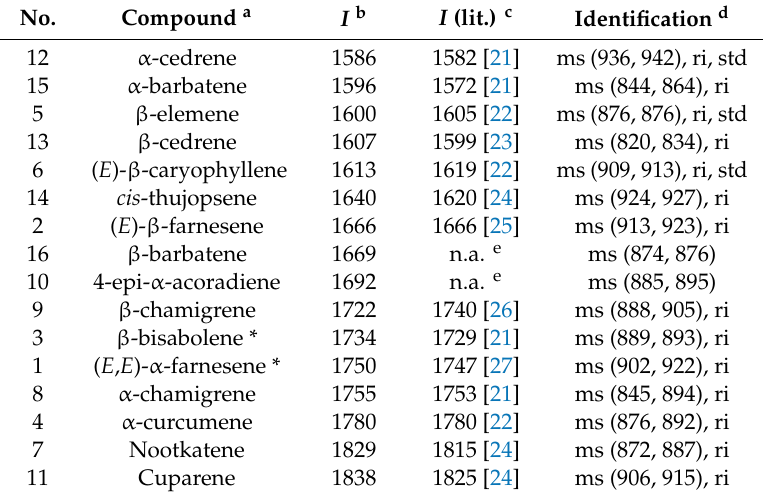
a Unidentified compounds are not listed. b Retention index I on a DB-WAX ultra-inert column. c Retention index data from the literature. d Compound identification is based on matching the mass spectrum to a library spectrum (ms, match factor and reverse match factor given in brackets) identical or closely matching the retention index (ri) and a comparison to a commercially available standard compound (std). e Retention index data on a WAX column were not available. * Only detectable in two out of three biological replicas. The recorded mass spectra of the listed sesquiterpene hydrocarbons can be found in Supplementary Table